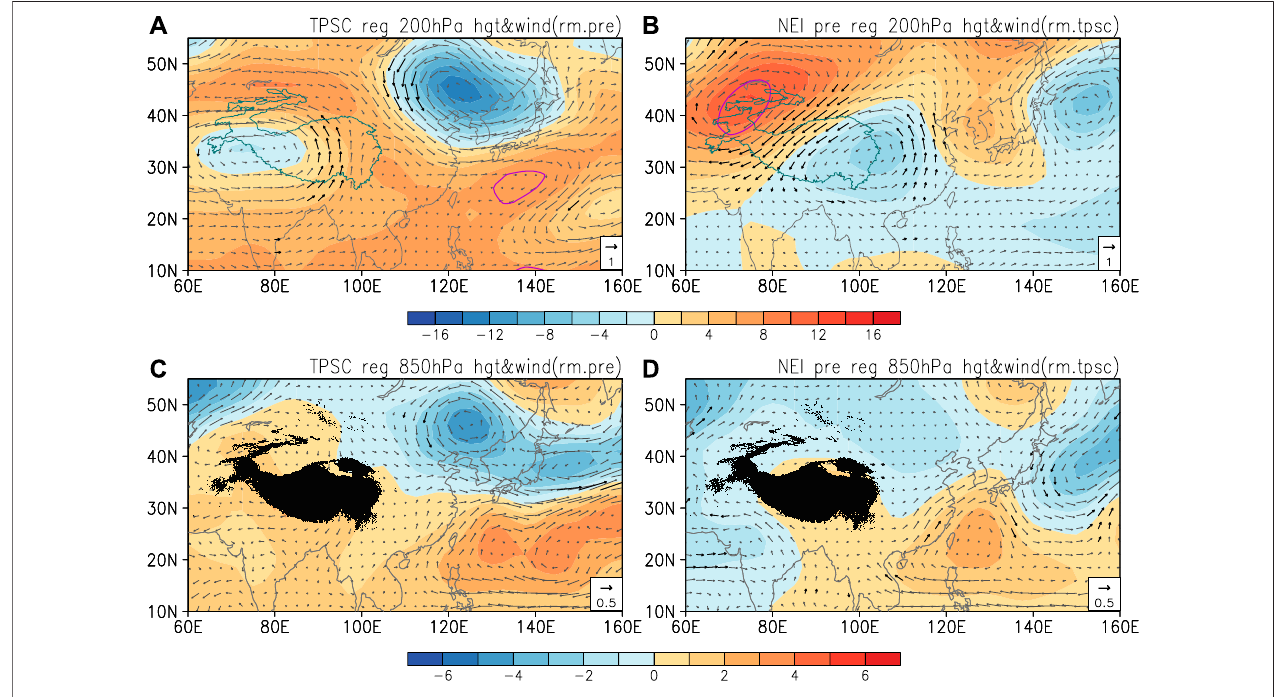
FIGURE 6 | Anomalies of (A, B) 200 hPa and (C, D) 850 hPa geopotential height (hgt) shading, gpm) and wind (vector, m/s) in summer obtained by linear regressionagainstthe (A,C) westernTibetanPlateausummersnowcoverindexand (B,D) northeastIndiansummerprecipitationindexfortheperiod2002 — 2020with the (A, C) northeast Indian summer precipitation signal and (B, D) western Tibetan Plateau summer snow cover signal removed. The scale for winds is shown at the bottom-right corner. The black vectors denote wind anomalies signi fi cant at the 95% con fi dence level. The purple contours denote geopotential height anomalies signi fi cant at the 95% con fi dence